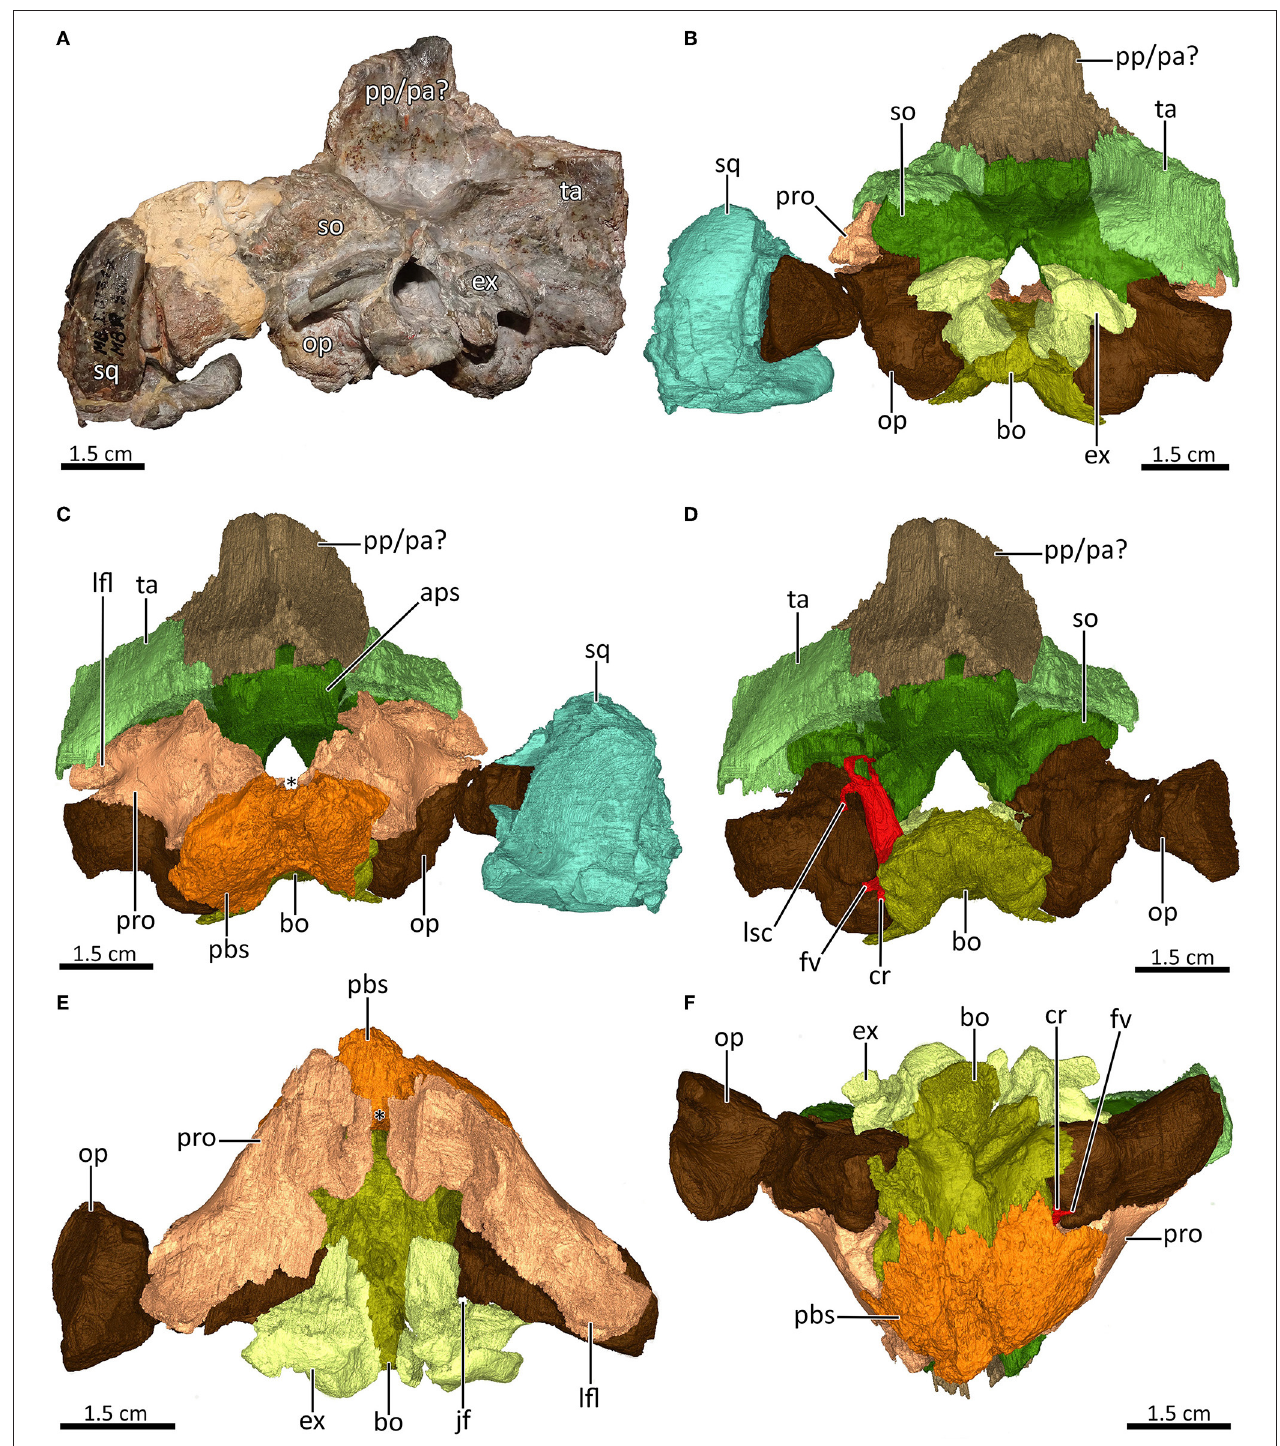
FIGURE 10 | Braincase of MB.R.995. (A) Photograph of the partial braincase in posterior view. (B) Posterior view of the reconstructed occiput. (C) 3D reconstruction of the braincase in anterior view. Asterisk indicates the location of the dorsum sellae. (D) Anterior view of the reconstructed occiput to illustrate the position of the inner ear within its bony housing with the parabasisphenoid, prootic and squamosal digitally removed. (E) Reconstructed braincase in dorsal and (F) ventral aspect, with the squamosal, tabular, supraoccipital, postparietal and parietal digitally removed in (E) and the squamosal digitally removed in (F) . Asterisk indicates the location of the dorsum sellae in (E) . aps, anterodorsal process of the supraoccipital; bo, basioccipital; cr, cochlea recess; ex, exoccipital; fv, fenestra vestibuli; jf, jugular foramen; lfl, lateral flange of the prootic; lsc, lateral semicircular canal; op, opisthotic; pa, parietal; pbs, parabasisphenoid; pp, postparietal; pro, prootic; so, supraoccipital; sq, squamosal; ta,